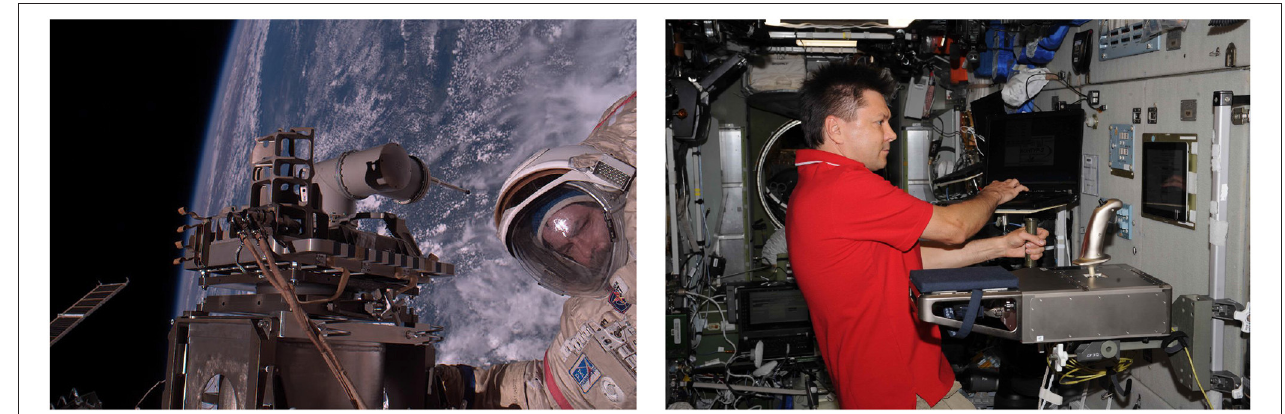
FIGURE 6 | The ROKVISS system mounted on a platform on the outside of the ISS ( left , credit: NASA). Cosmonaut Oleg Kononenko with the Kontur-2 joystick on board the ISS ( right , credit: ROSCOSMOS/O. Kononenko).